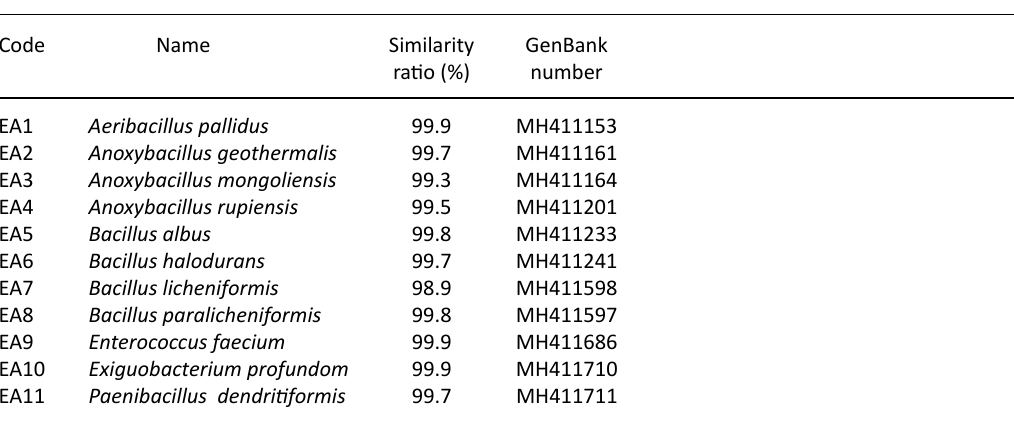
Table 1. Molecular identifications of the isolates